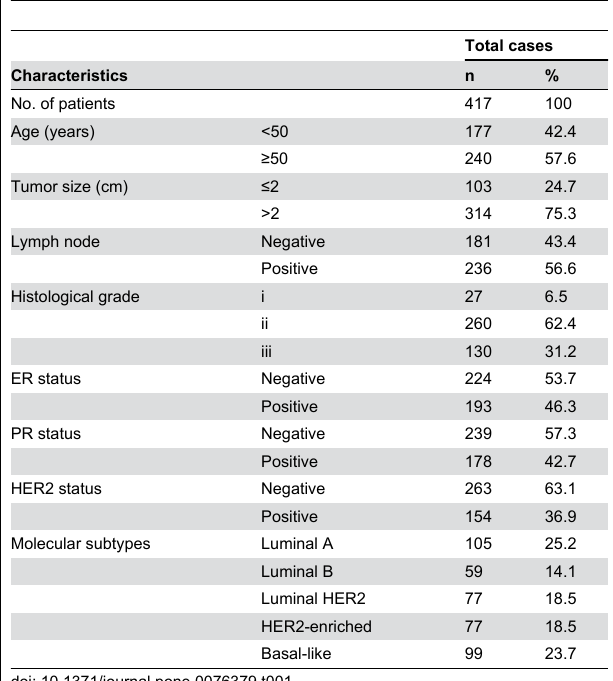
Table 1. Clinicopathologic characteristics of BC patients.